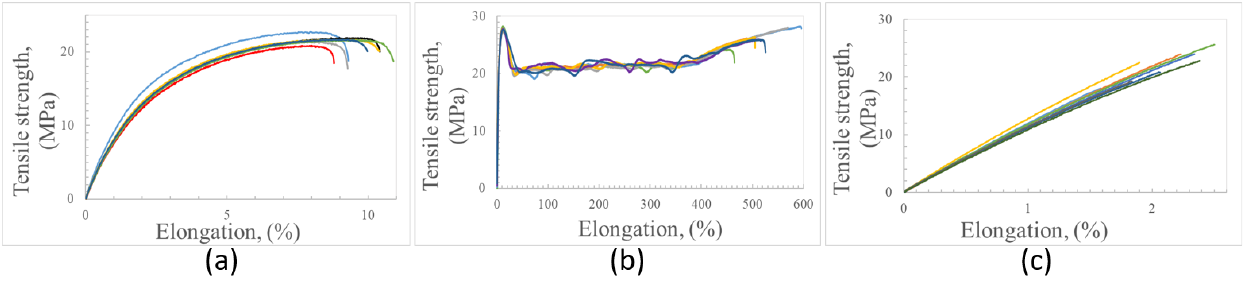
Figure 7. Tensile stress–strain curves for recycled PE ( a ), PP ( b ) and PET ( c ). The polypropylene tensile curves (Figure 7b) show initial elastic deformation, yield- ing, and then progressive important elongation before breaking (about 520%). Commer- cial PP products can show a very wide range of strain values at break, with the highest